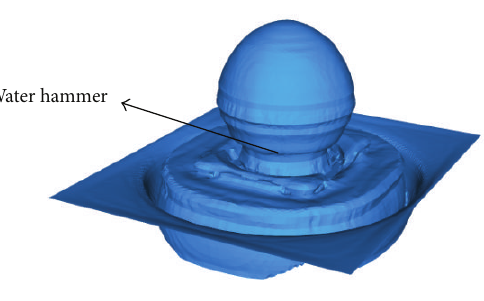
Figure 16: Geometric description of water hammer from present numerical